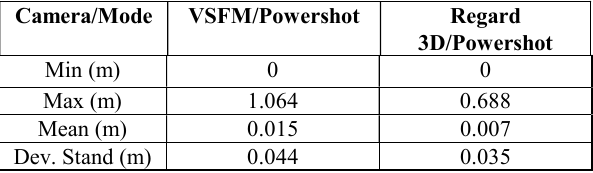
Table 5: Statistical values of the comparisons between the